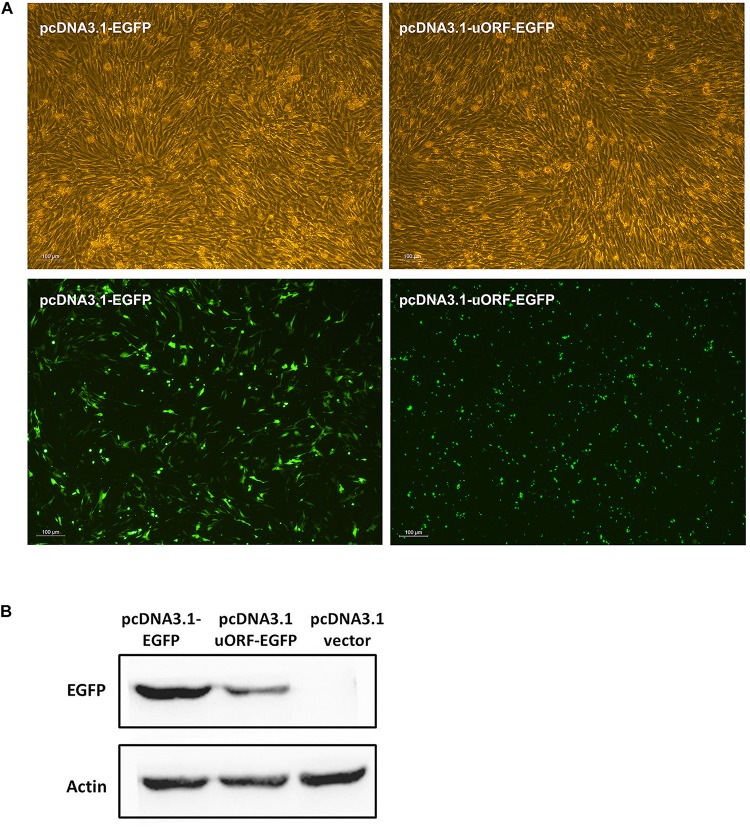
Translation can be initiated at the uAUG of the PPARγ1 uORF. (A) The pcDNA3.1-EGFP and pcDNA3.1-uORF-EGFP were respectively transiently transfected into ICP1 cells, 48 h post-transfection, the green fluorescence signal was visualized under a fluorescence microscope. (B) Lysates from the cells transfected with pcDNA3.1-EGFP and pcDNA3.1-uORF-EGFP, EGFP or uORF-EGFP fusion protein was immunoblotted with an anti-EGFP antibody. Actin was used as a loading control.